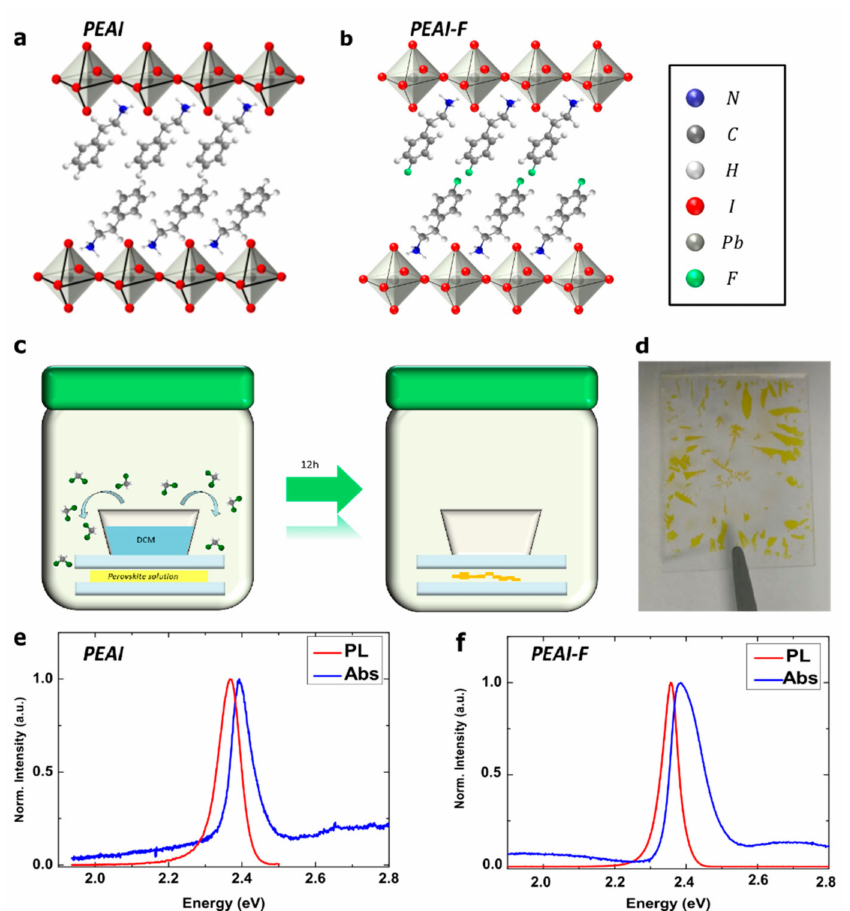
Figure 1. ( a , b ) Three-dimensional structure of synthetized PEAI and PEAI-F perovskites. ( c ) Sketch of antisolvent vapor-assisted crystallization method: after 12 h the perovskite solution is fully transformed into perovskite single crystals. ( d ) PEAI single crystals grown on a glass substrate. ( e ) Normalized PL (red line) and Abs (blue line) spectra of PEAI at room temperature. ( f ) Normalized PL (red line) and Abs (blue line) spectra of PEAI-F at room